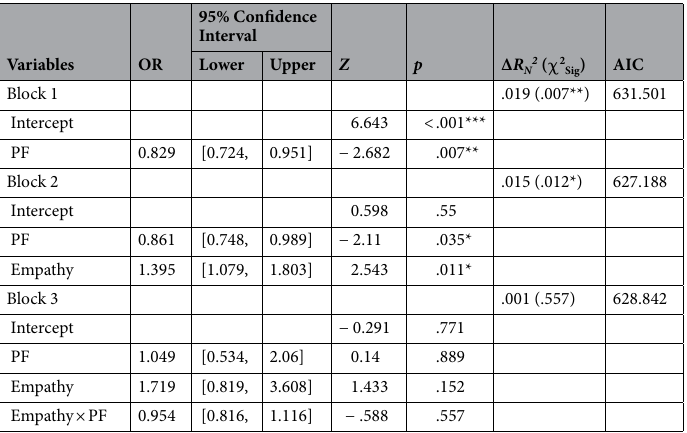
Table 3. Hierarchical binomial logistic regression of vaccination status predicted by pandemic fatigue, empathy, and empathy × pandemic fatigue interaction. The outcome variable is the probability of being vaccinated against COVID-19. OR odds ratio, PF pandemic fatigue, AIC akaike information criterion, R N 2 nagelkerke’s R 2 . * p < .05, ** p < .01, *** p <